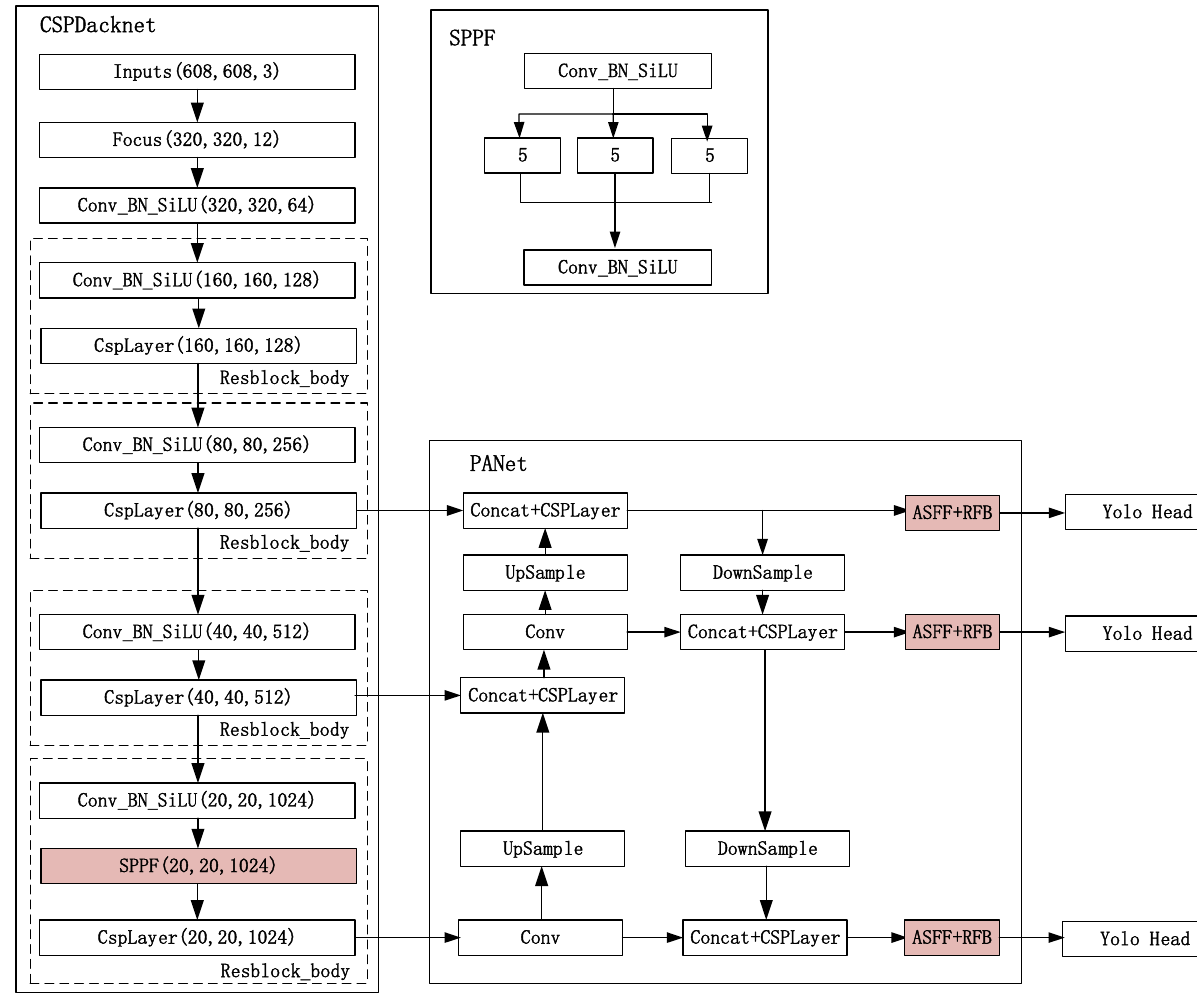
Figure 4. ASFF-YOLOv5 structure diagram.